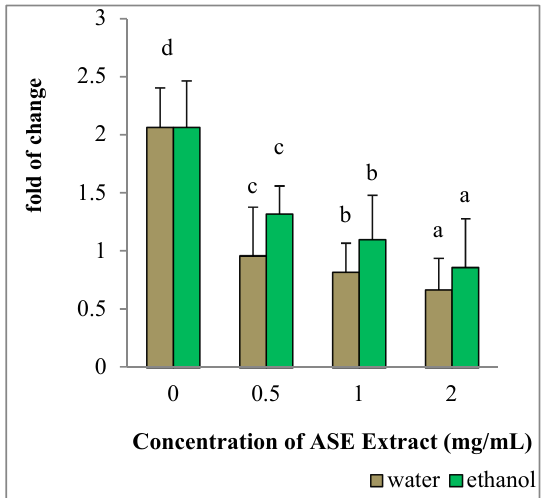
Figure 4. Effect of ASE crude extracts on Bcl-2 gene expression in HepG2 cells. The mRNA levels for each gene are expressed as fold of change (2 − ∆∆ Ct ) relative to the untreated control (CTRL-), defined as 1 (mean ± SD; n = 3), and normalized to the Glyceraldehyde-3-Phosphate-Dehidrogenase (GAPDH). Data are expressed as mean ± SD referred to the control. Bars marked by unlike letters within a group are significantly different at p < 0.05, according to Duncan’s Multiple Range Test (DMRT).